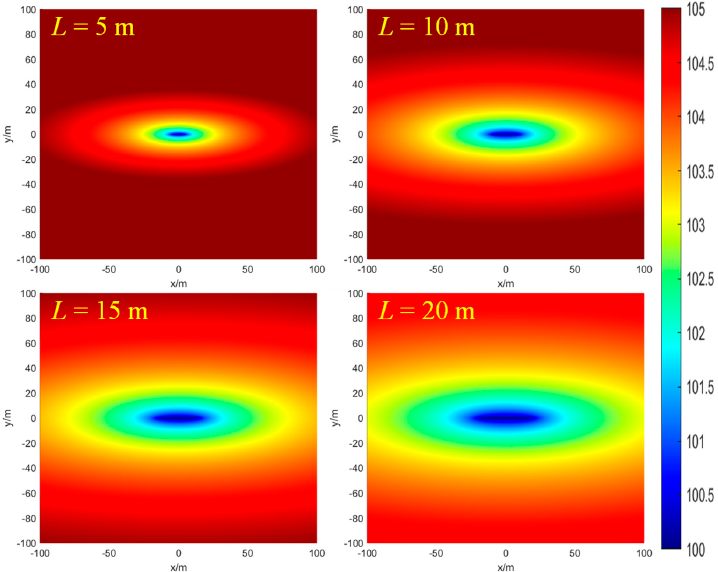
Figure 6. Distribution of pressure field of fractured coal seam under heterogeneous state.